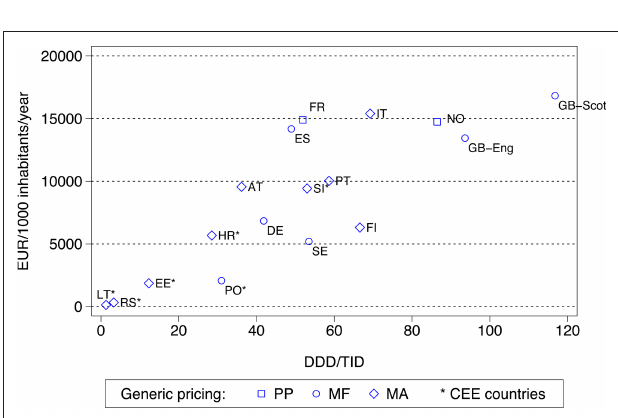
FIGuRE 4 | utilization (DDD/TID) and overall expenditure (€/1000 inhabitants/year) for the statins among European countries in 2007 (Italy 2008, Serbia 2008). Standard EU country abbreviations have been used. ES = Catalonia. Republic of Ireland not included as the GMS population has greater morbidity than the general